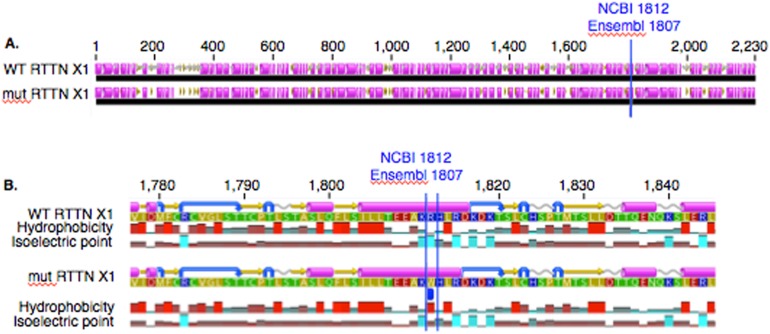
Alignment of WT and mutant RTTN protein with predicted hydrophobicity and isoelectric point.Low (A) and high magnification (B) of predicted protein changes. Replacement of arginine with tryptophan at position 1,812 changes alpha helix to beta strand at position 1,816. Alpha helices (pink), coils (gray line), turns (blue arrows), and beta strands (yellow arrows).